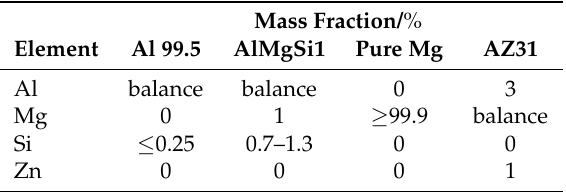
Table 2. Chemical compositions of the materials